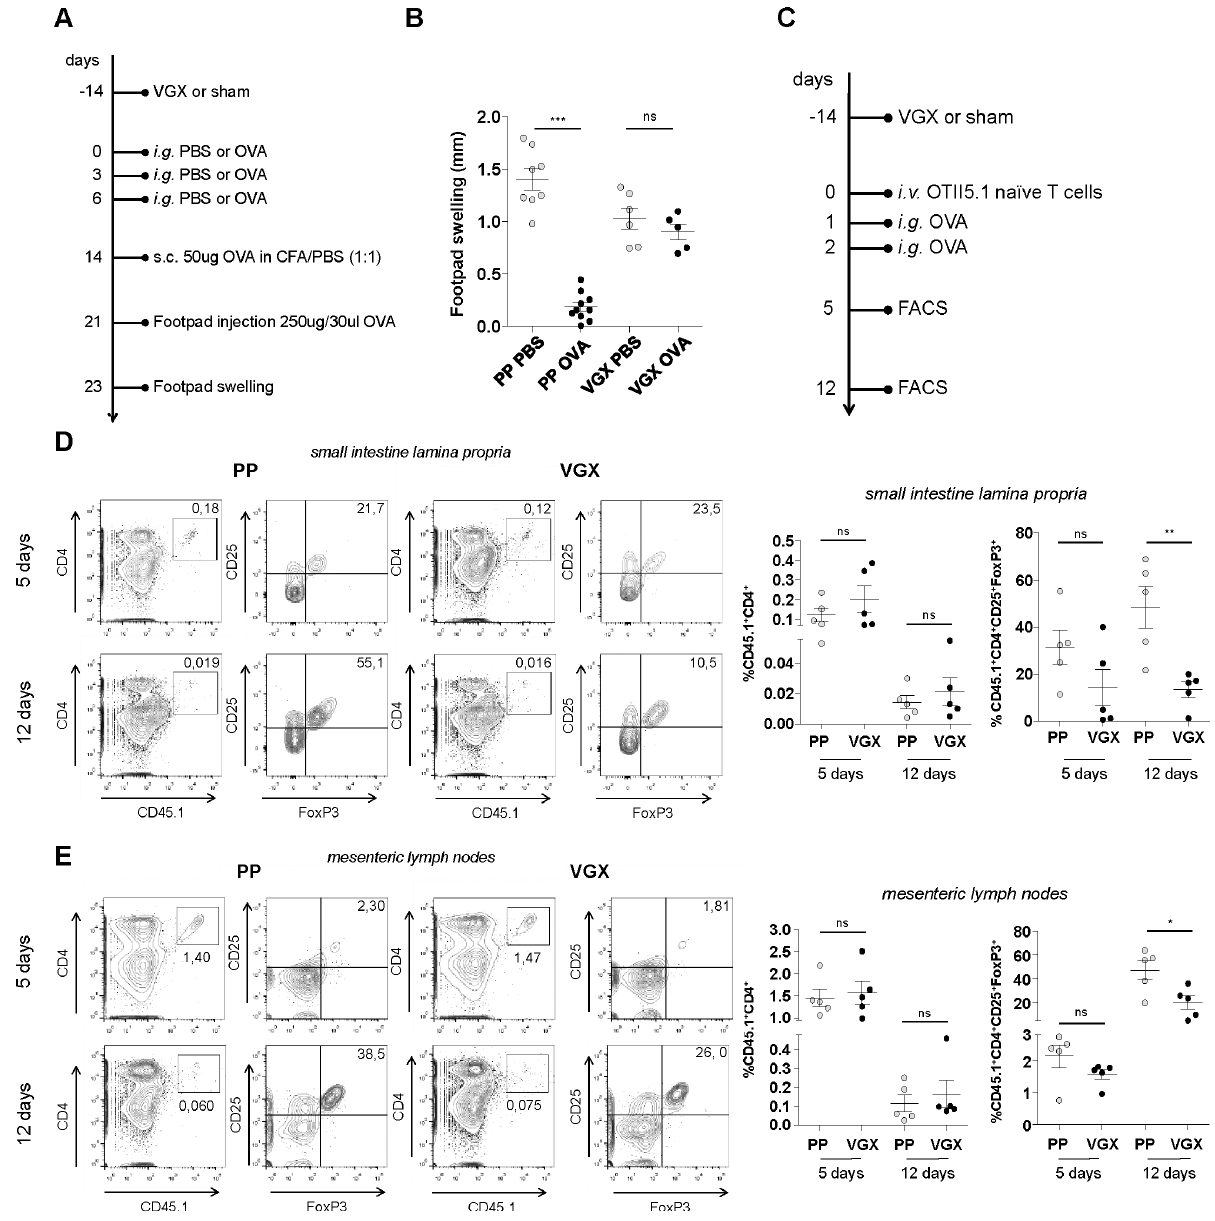
Figure 1. Vagotomy affects induction of oral tolerance and accumulation of antigen-specific regulatory T cells in the lamina propria. (A) Wild type C57BL/6 mice were subjected to vagotomy (VGX) or pyloroplasty (PP) two weeks before 3 intragastric gavages ( i.g. ) of ovalbumin (OVA) to induce oral tolerance. After 1 wk, all mice were subcutaneously ( s.c. ) immunized against OVA in CFA and challenged in the footpad 7 d later with heat-aggregated OVA. Footpad swelling was measured 48 h after OVA challenge by foodpad injection. Footpad swelling was calculated as difference between prior to and 48 h after injection of OVA. (B) Footpad swelling was calculated in mice receiving 3 intragastric gavages ( i.g. ) of PBS or OVA and subjected to VGX or PP. In PP alone mice the reduction in footpad swelling is indicative of establishment of oral tolerance while VGX failed to develop oral tolerance. (C) OT-II naïve CD4 T cells were adoptively transferred into syngeneic VGX and PP recipients before two oral doses of 50 mg OVA. Conversion and accumulation of OT-II naïve CD4 T cells into Tregs were analyzed 5 and 12 d after adoptive transfer. Representative dot plot of transferred OTII T cells (CD45.1 + CD4 + cells) and Tregs (CD45.1 + CD4 + CD25 + FoxP3 + cells) generated out of adoptively transferred OT-II CD45.1 + CD4 + cells and frequencies in small intestine lamina propria (D) and MLNs (E) are dis- played. Circles represent individual mice. Data are representative of two independent experiments. Statistical significance was determined with unpaired Student t -test (* P < 0.05, ** P < 0.01, *** P < 0.001, ns, not